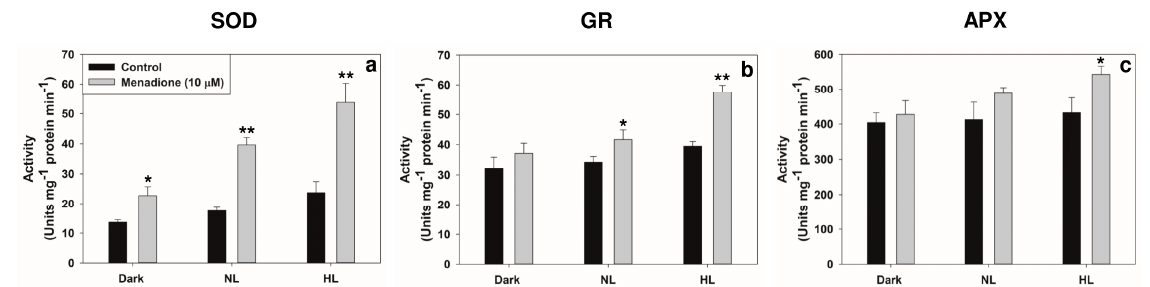
Figure 4. The activities of typical antioxidant enzymes superoxide dismutase, SOD ( a ), glutathione reductase, GR ( b ), ascorbate peroxidase, APX ( c ) in leaf extracts on treatment with menadione in normal (NL) or high light (HL). Each data point is the average of three replicates, and error bars represent ± SE. Asterisks indicate the significance of MD effect compared to the respective control. * p < 0.05; ** p < 0.001.